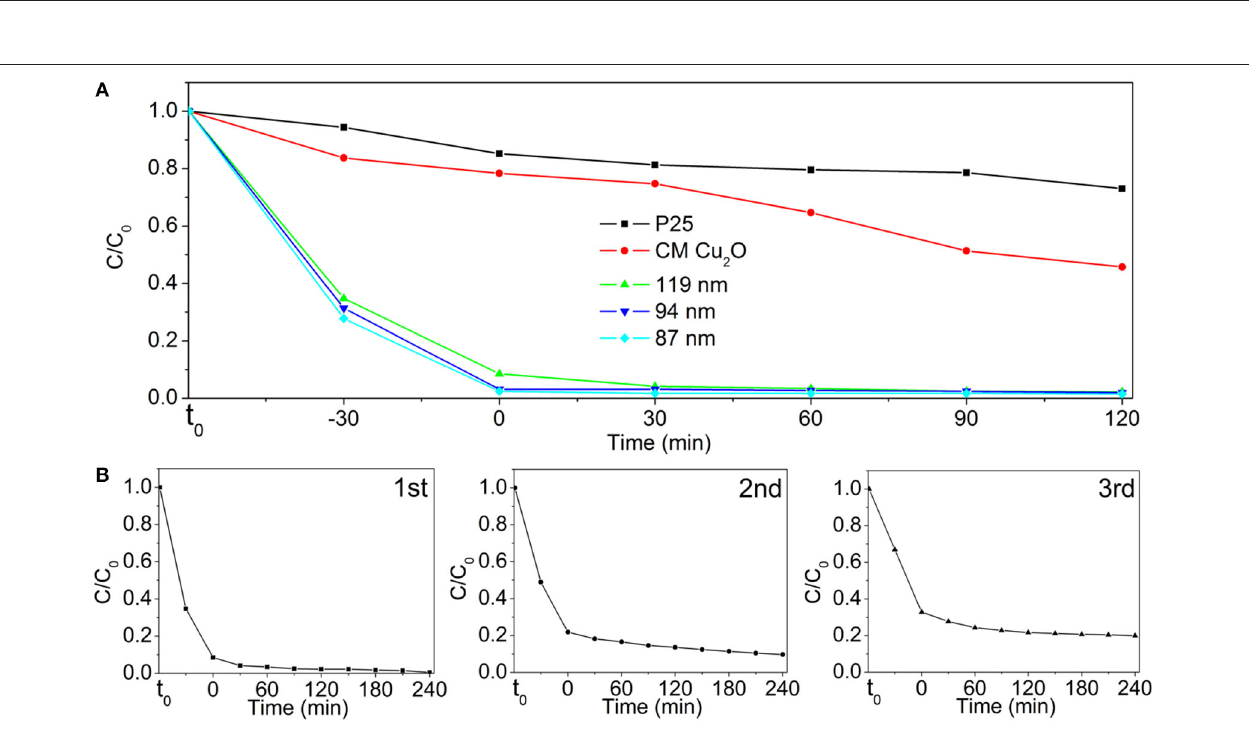
FIGURE 7 | (A) Photodegradation of MO over P25, commercial Cu 2 O (CM Cu 2 O), and as-prepared Au@Cu x O core–shell MPNSs with different diameters under visible light irradiation. (B) Cycling runs in the photodegradation of MO in the presence of 119-nm Au@Cu x O core–shell MPNSs. t 0 refers to the time point at which no catalyst is added to MO dispersion